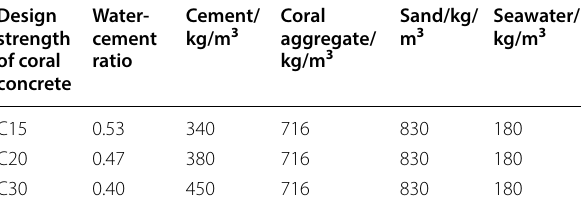
Table 4 Mix proportion of coral concrete. Design strength